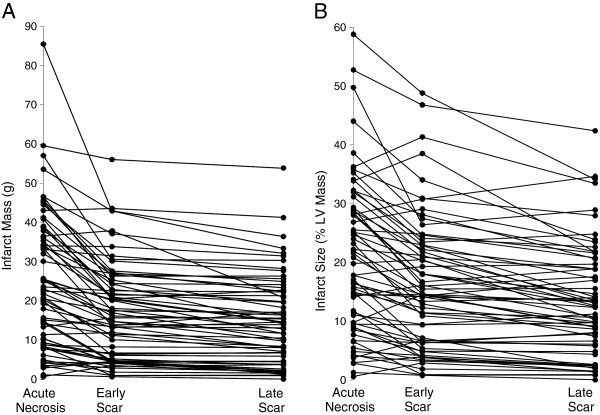
Changes over time in infarct mass. Scatter plot showing the changes in absolute infarct mass over time (A) and the changes in infarct size as a percent of left ventricular mass over time (B) for all patients.